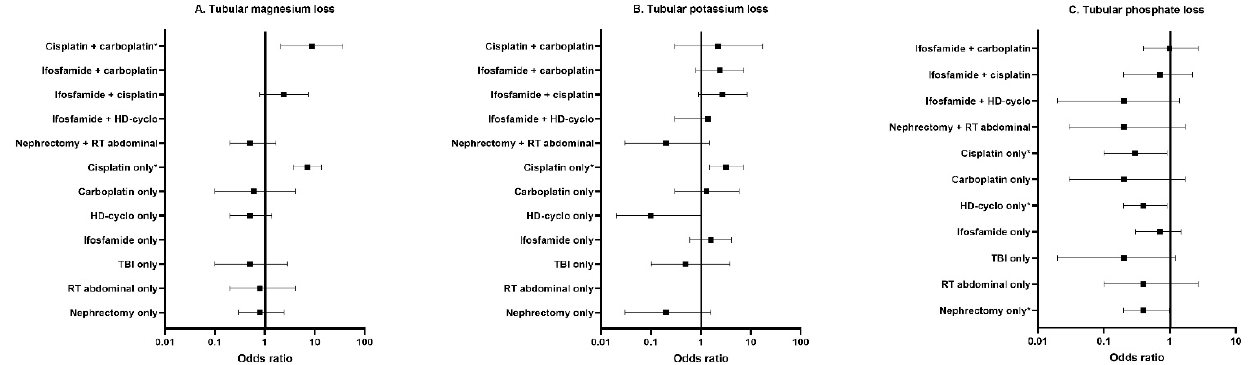
Figure 2. Multivariable logistic regression analyses including mutually exclusive treatment groups for tubular outcomes including: ( A ) tubular magnesium loss; ( B ) tubular potassium loss; ( C ) tubular phosphate loss. This figure displays the odds ratios in CCS compared to controls. Exact values of the odds ratios are listed in Table S1. The square represents the odds ratio, and the horizontal lines represent the 95% confidence interval. The vertical line represents the value 1 (no difference between CCS and controls). The model for tubular magnesium loss is corrected for age at study, estimated glomerular filtration rate and albumin-to-creatinine ratio. The models for tubular potassium loss are corrected for age at study. The model for tubular phosphate loss is corrected for age at study and sex. * = p -value < 0.05. Abbreviations: CCS, childhood cancer survivors; HD-cyclo, high-dose cyclophosphamide; RT, radiotherapy; TBI, total body